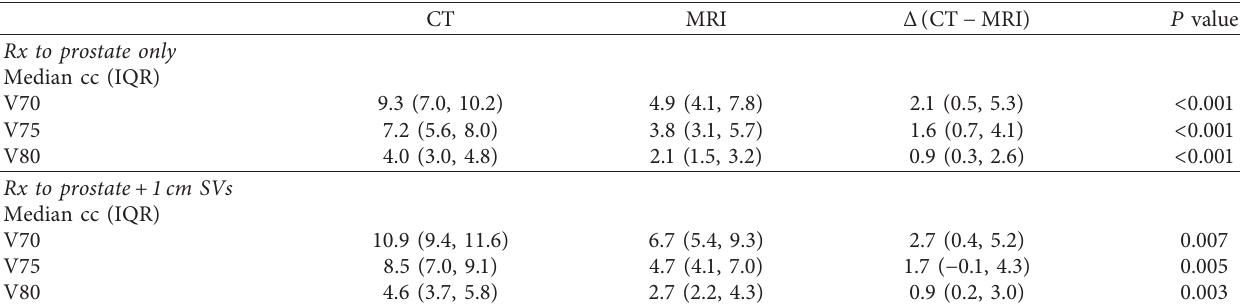
Figure 1: Rectum dose-volume histogram for CT- versus MRI-based planning. The volume of rectum at each dose level in 8 cGy intervals was averaged over 15 trial participants and is shown as a single dose-volume histogram for CT- versus MRI-based radiotherapy plans. Hatched area shows volume reduction of expected clinical benefit. Table 1: Rectal volume exposed to high dose radiation.